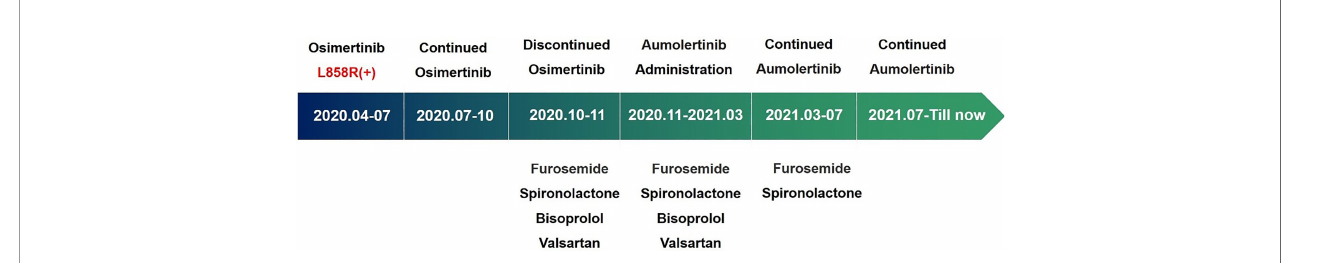
FIGURE 3 | The medicine administration with indicated time periods shown as a fl owchart